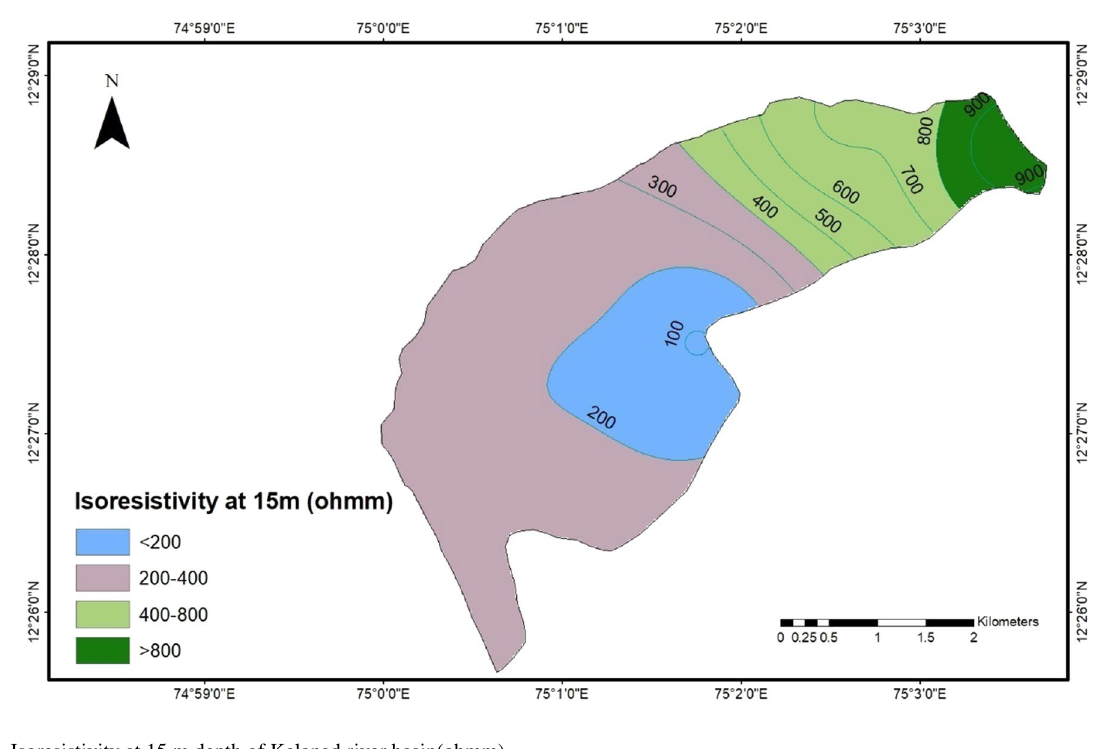
Fig. 10 Isoresistivity at 15 m depth of Kalanad river basin(ohmm)